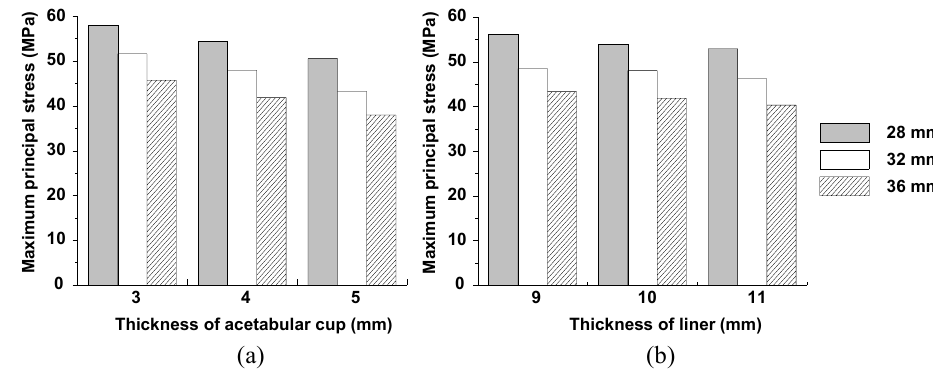
Fig. 6 Comparison of maximum principal stress with different liners. (a) Maximum stress with liner thickness of 9, 10, and 11 mm and (b) maximum stress with acetabular cup thickness of 3, 4, and 5